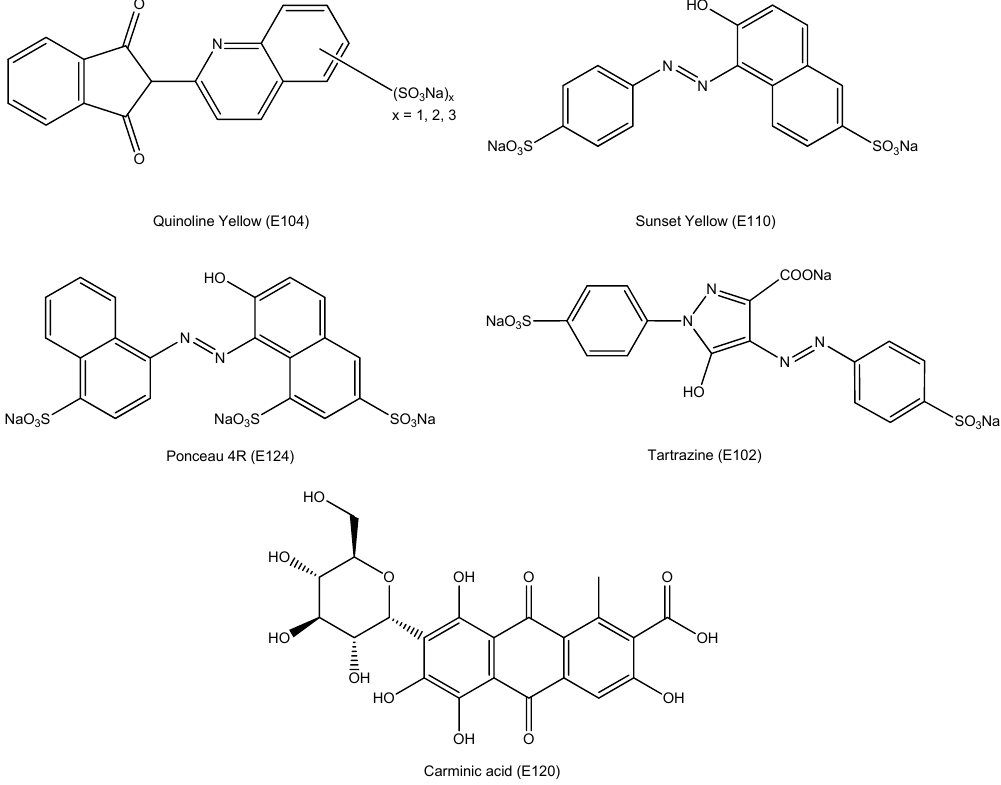
Figure 1. Chemical structures of the studied dyes.